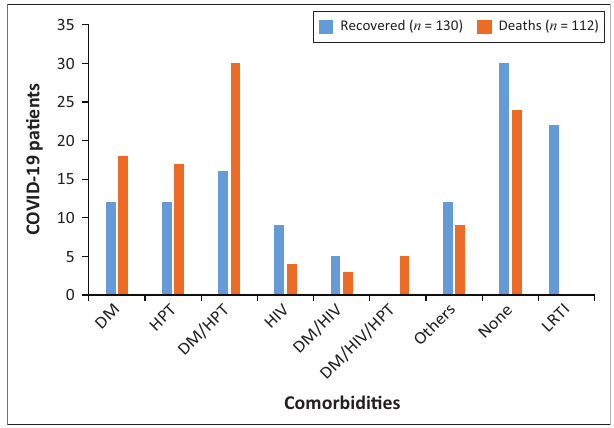
FIGURE 4: Clinical outcomes of COVID-19 hospitalised patients and associated comorbidity at Mthatha Regional Hospital ( n =